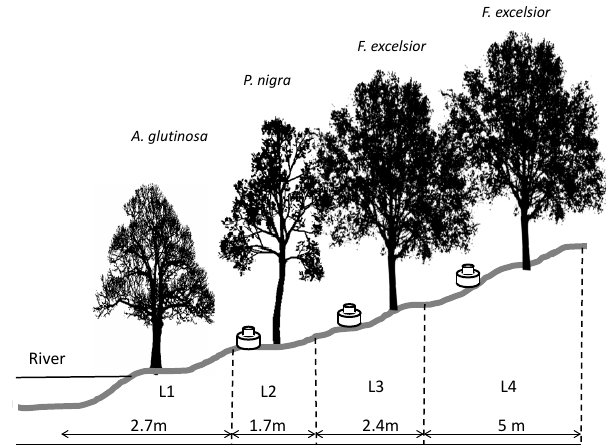
Figure 1. Sketch of levels along a gradient of soil water availability with tree species distribution and SR H chamber